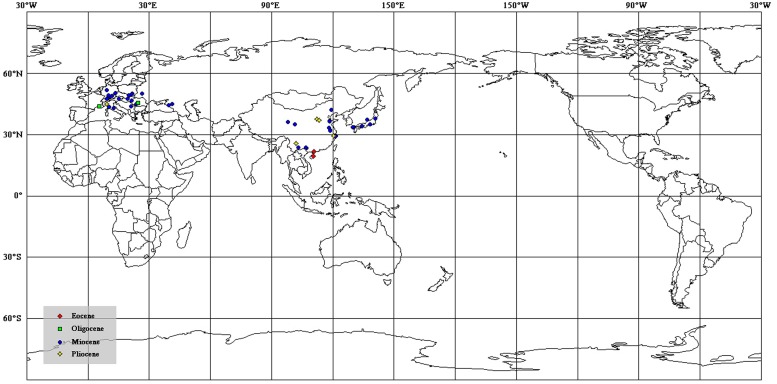
The distribution of megafossil records of Podocarpium on the modern world map [data from Liu et al. (2001b) and Wang et al. (2007)].